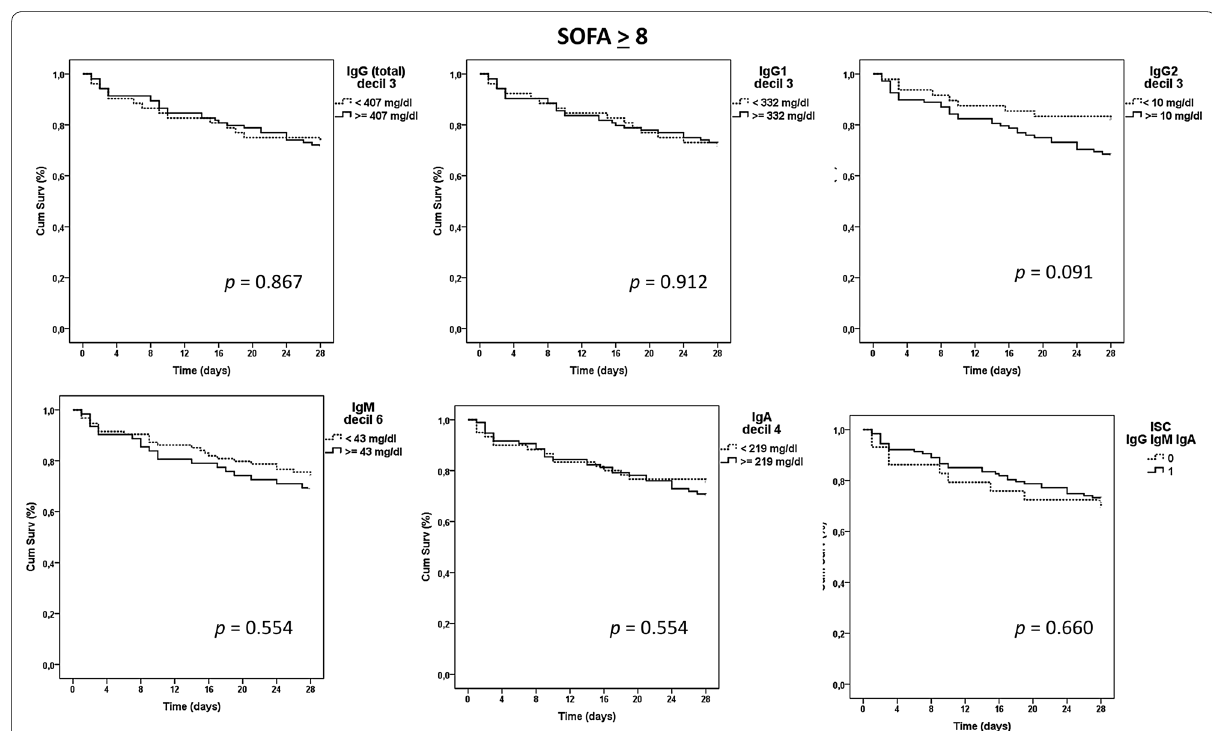
Fig. 2 Kaplan–Meier analysis for survival depending on immunoglobulin levels in the group with SOFA